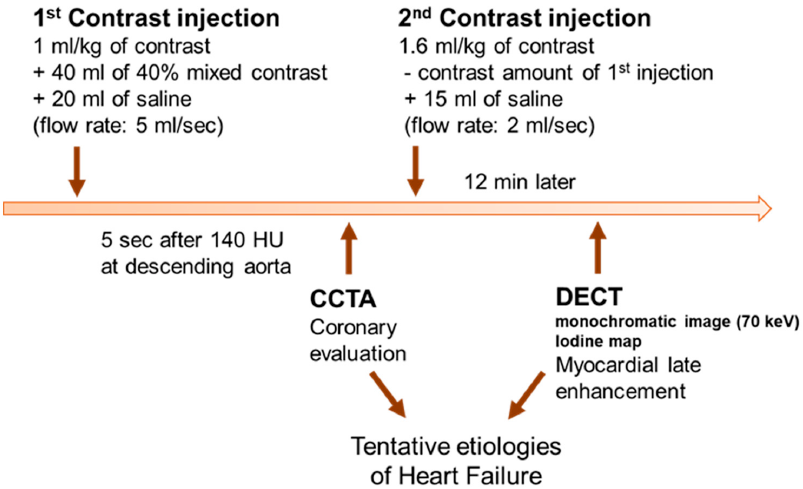
Figure1. FlowdiagramforcardiacCTscanning. CCTA = coronarycomputedtomographicangiography; Figure 1. Flow diagram for cardiac CT scanning. CCTA = coronary computed tomographic DECT = dual-energy computed angiography; DECT = dual-energy computed tomography.